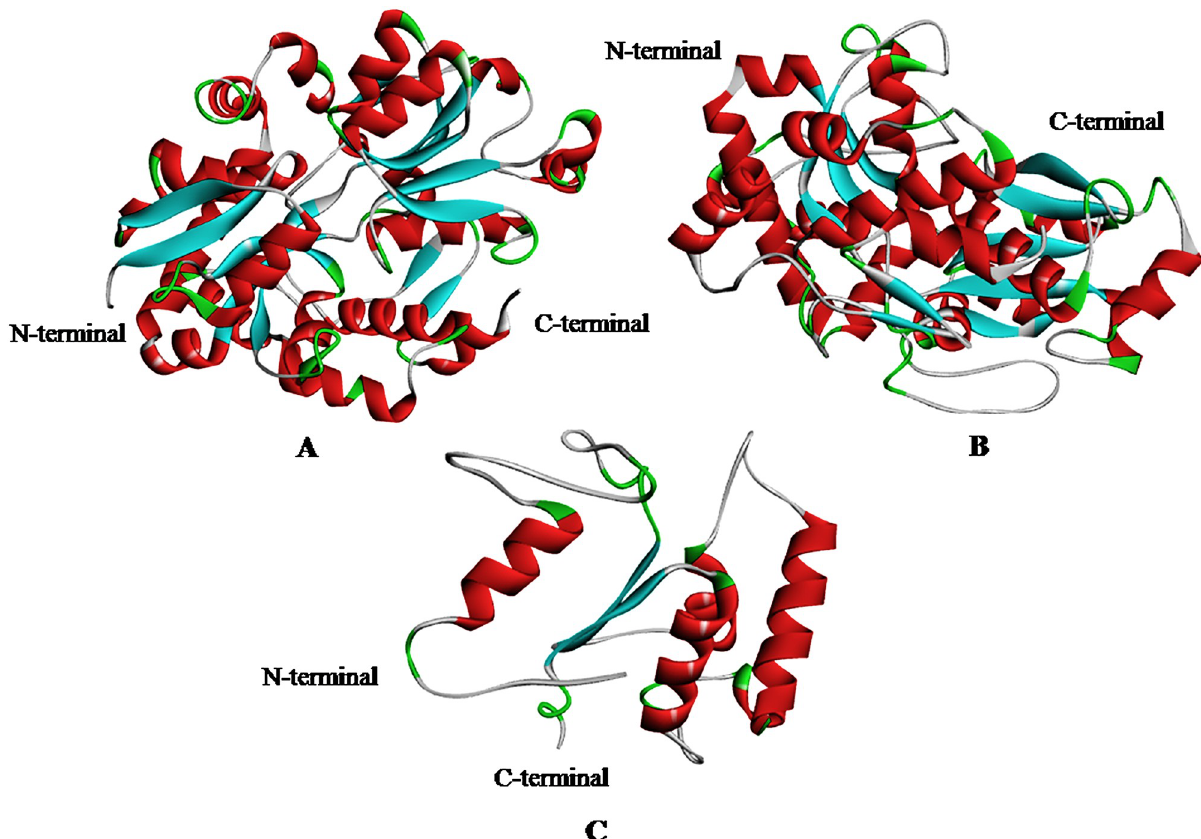
Fig 6. Homology model of nrtACD proteins. Models are presented as ribbon structure. Alpha helices are in red, beta sheets in cyan, turn in grey and coil in green color. (A) nrtA, (B) nrtC and (C) nrtD.